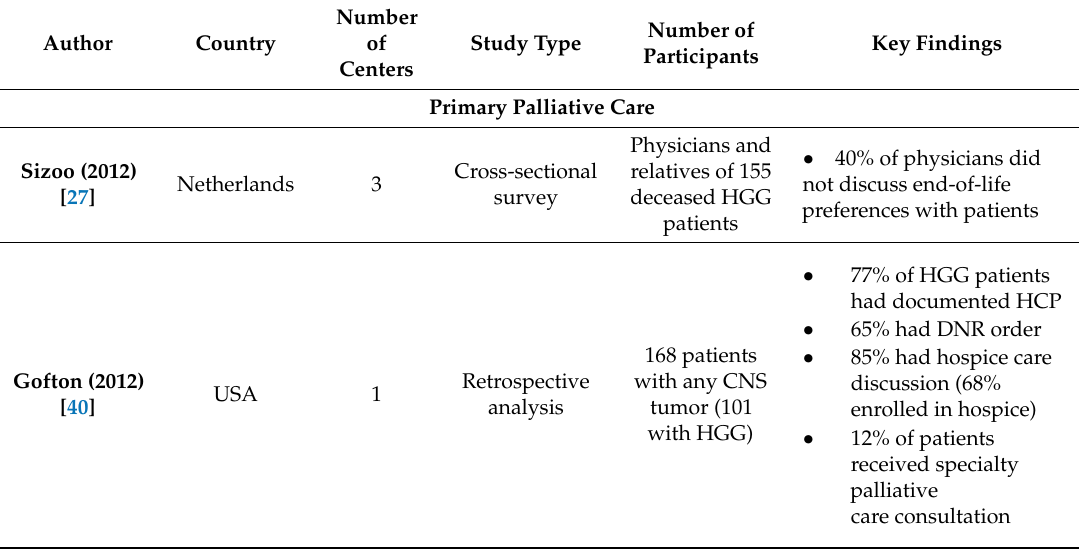
Table 3. Summary of the literature on current utilization of primary palliative care, specialty palliative care, and hospice among patients with